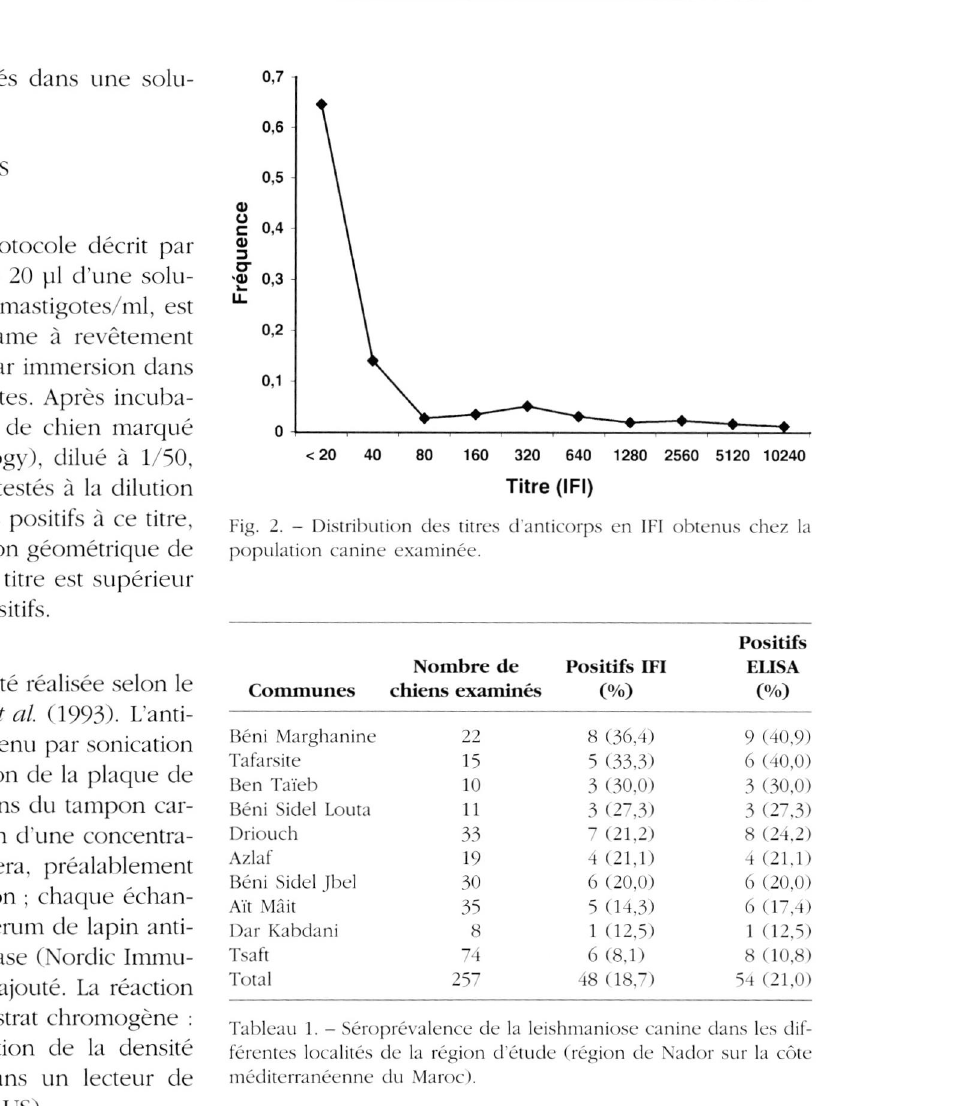
Nombre de Positifs IFI